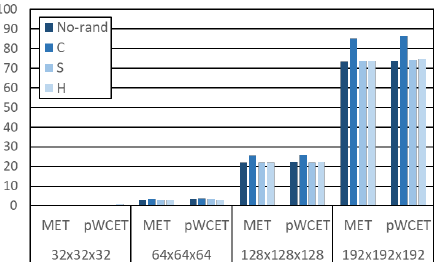
Figure 10. Absolute maximum execution time (MET) and pWCET estimate (in seconds) at an exceedance probability of 10 − 6 per run for the different configurations.